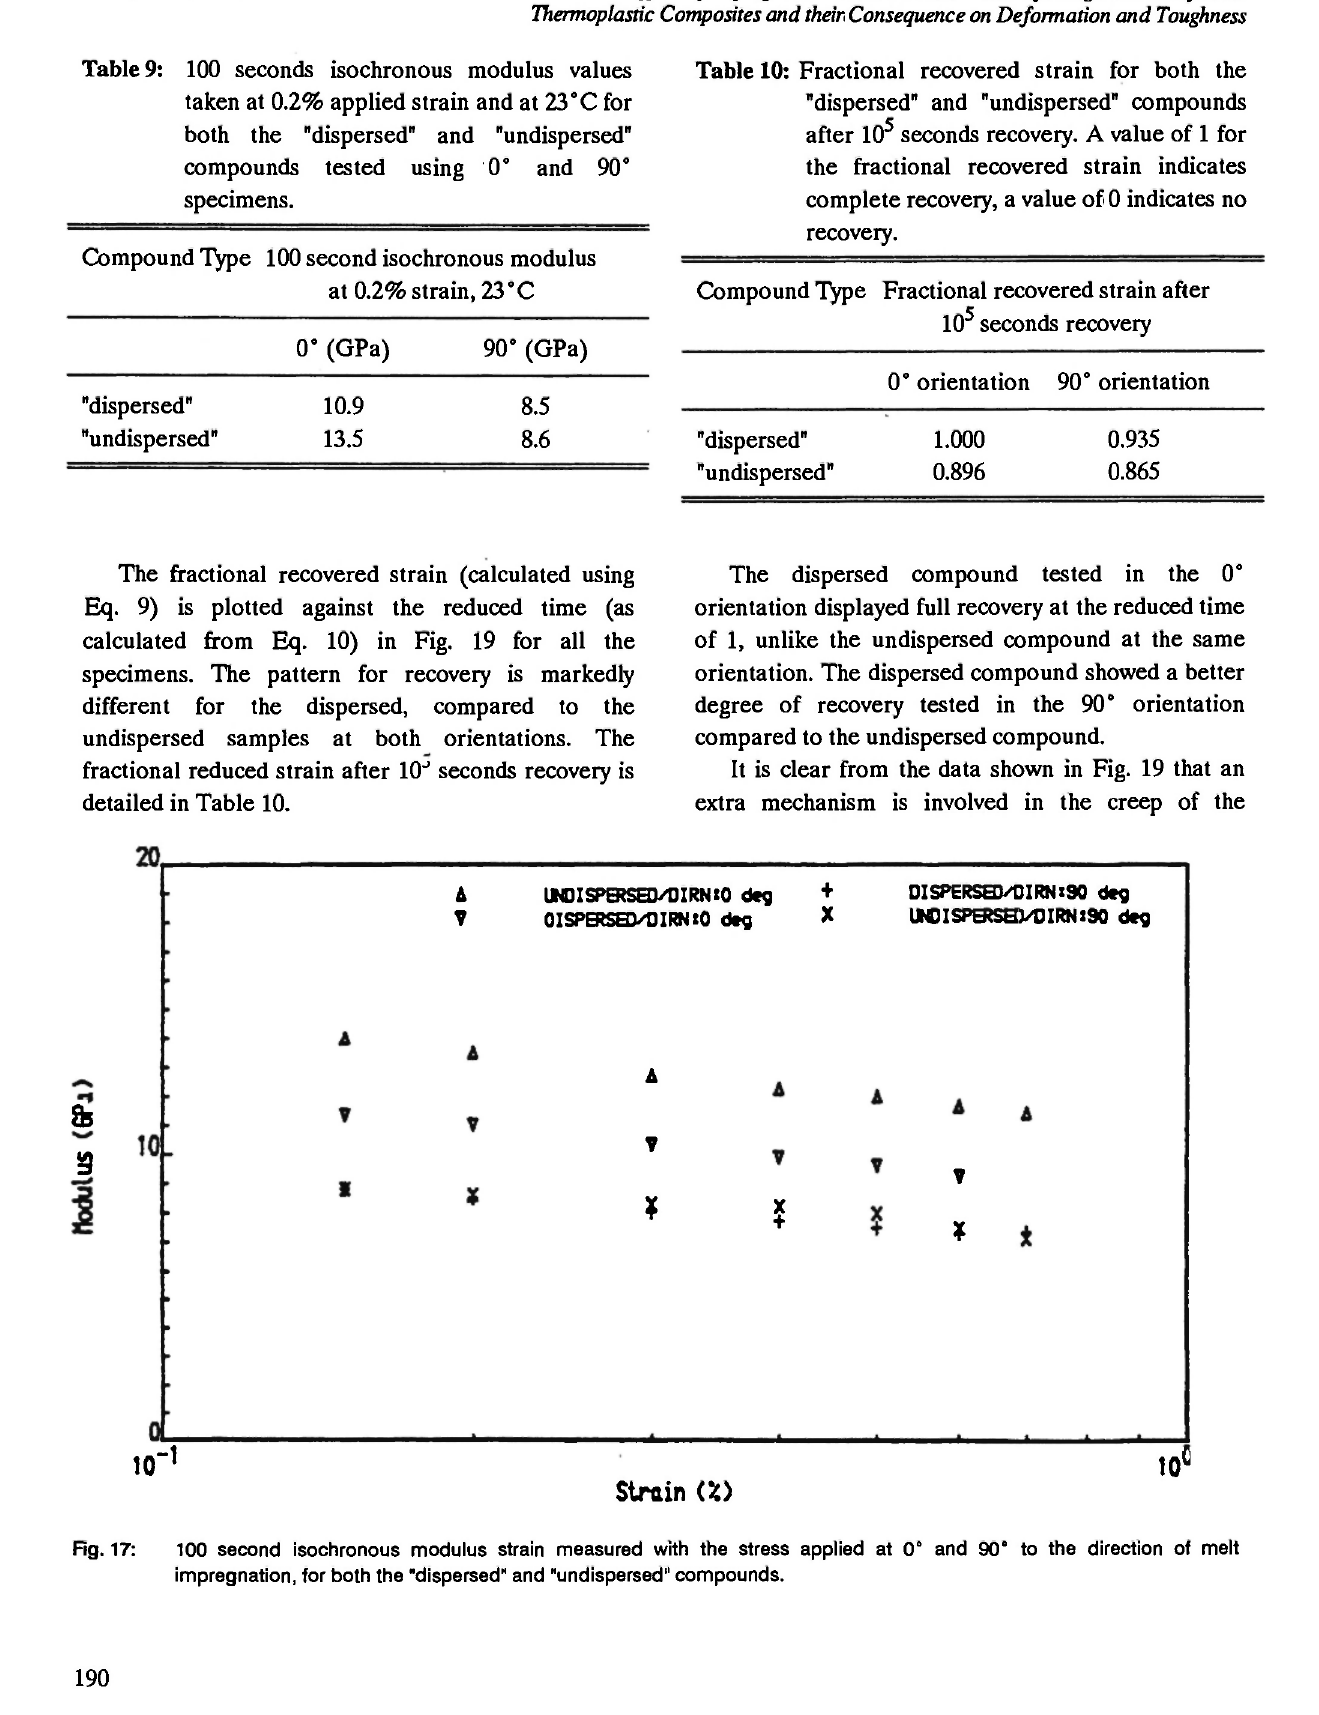
Table 9: 100 seconds isochronous modulus values taken at 0.2% applied strain and at 23 °C for both the "dispersed" and "undispersed" compounds tested using 0° and 90° specimens.